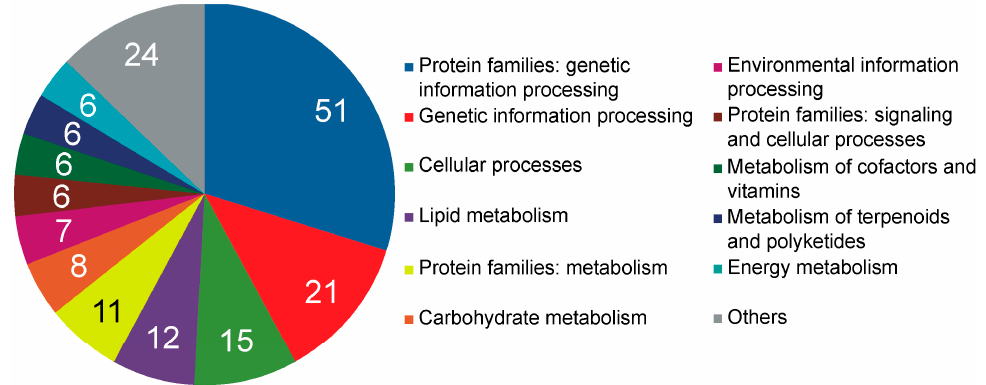
Figure 5. Functional classification of differentially expressed genes (DEGs) between colpate and po- rate species. Each DEG was classified into KEGG functional categories using GhostKoala mapping tool. Numbers indicate the number of DEGs classified in each category.